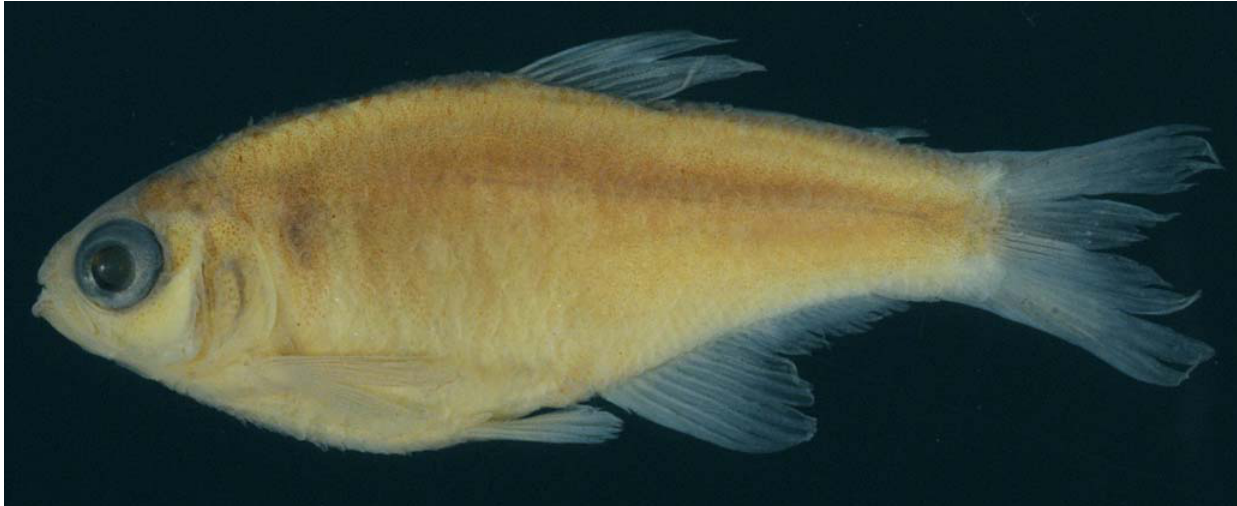
Fig. 4. Lophiobrycon weitzmani , paratype, adult female. MZUSP 83353, 21.8 mm SL; same locality data as in Fig.